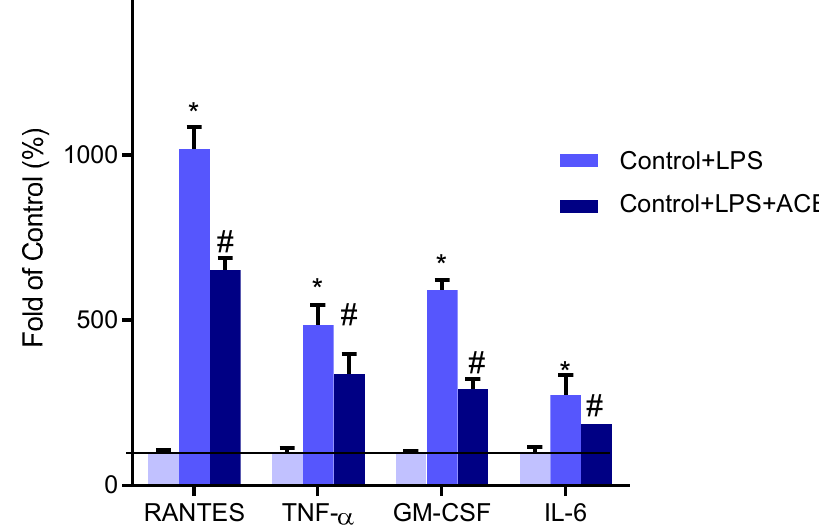
Figure 7. The level of evaluated cytokines and chemokines increased significantly compared to the controlafterLPS-treatmentindicatedby*. #indicatesthesignificantchangesincytokinesinLPS-induced inflammation and ACE 50 treatment compared to the level of cytokines in LPS-induced inflammation without ACE 50 . Results are expressed in the percentage of the control (100% is represented by the solid lines). Data are expressed as the mean ± SEM of four individual experiments. ACE 50 , 50 µ g / mL anthocyanin extract. Interleukin-6 (IL-6), regulated on activation, normal T cell expressed and secreted (RANTES), granulocyte-macrophage colony-stimulating factor (GM-CSF), and tumor necrosis factor alpha (TNF- α